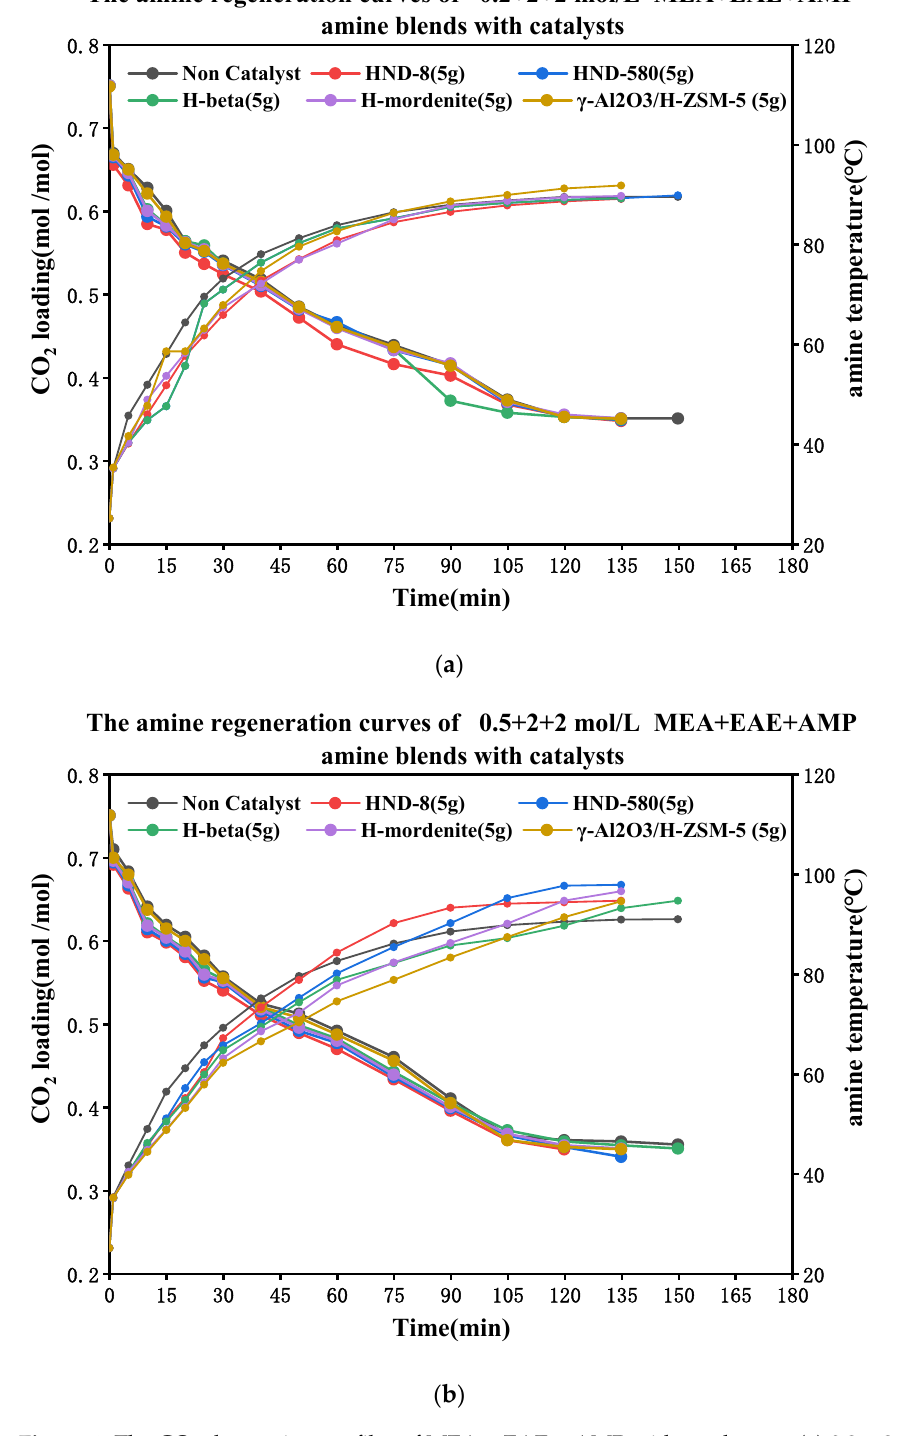
Figure 4. The CO 2 desorption profiles of MEA + EAE + AMP with catalysts at ( a ) 0.2 + 2 + 2 mol/L and ( b ) 0.5 + 2 + 2 mol/L.